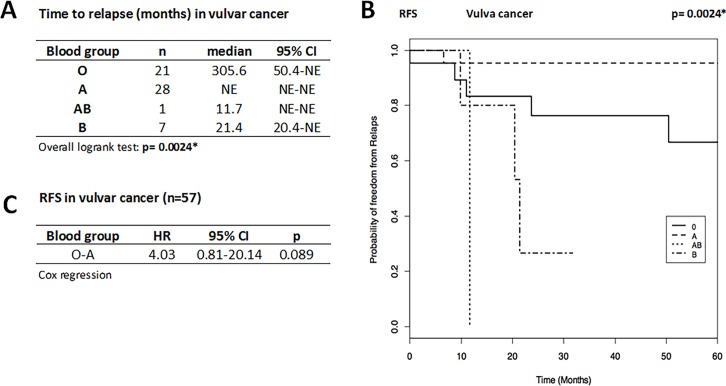
Time to relapse (A), Kaplan-Meier curve for RFS (B), and HR for disease recurrence (C) in vulvar cancer patients (n = 57). BG O patients tend to have increased risk for relapse compared to A patients A (HR O vs A = 4.03, 95%CI: 0.81–20.14, p = 0.089), i.e. A patients have better prognosis with a trend to longer RFS than patients with BG O. Time to relapse presented as median (months) and 95%CI and compared by overall Logrank Test. Disease recurrence risk presented as HR and 95%CI by Cox regression (only possible for O vs A owing the small sample size for AB and B). Statistical significance marked by asterisks (*) or highlighted. NE, not estimable. RFS given as probability of freedom from relapse as a function of time (months).